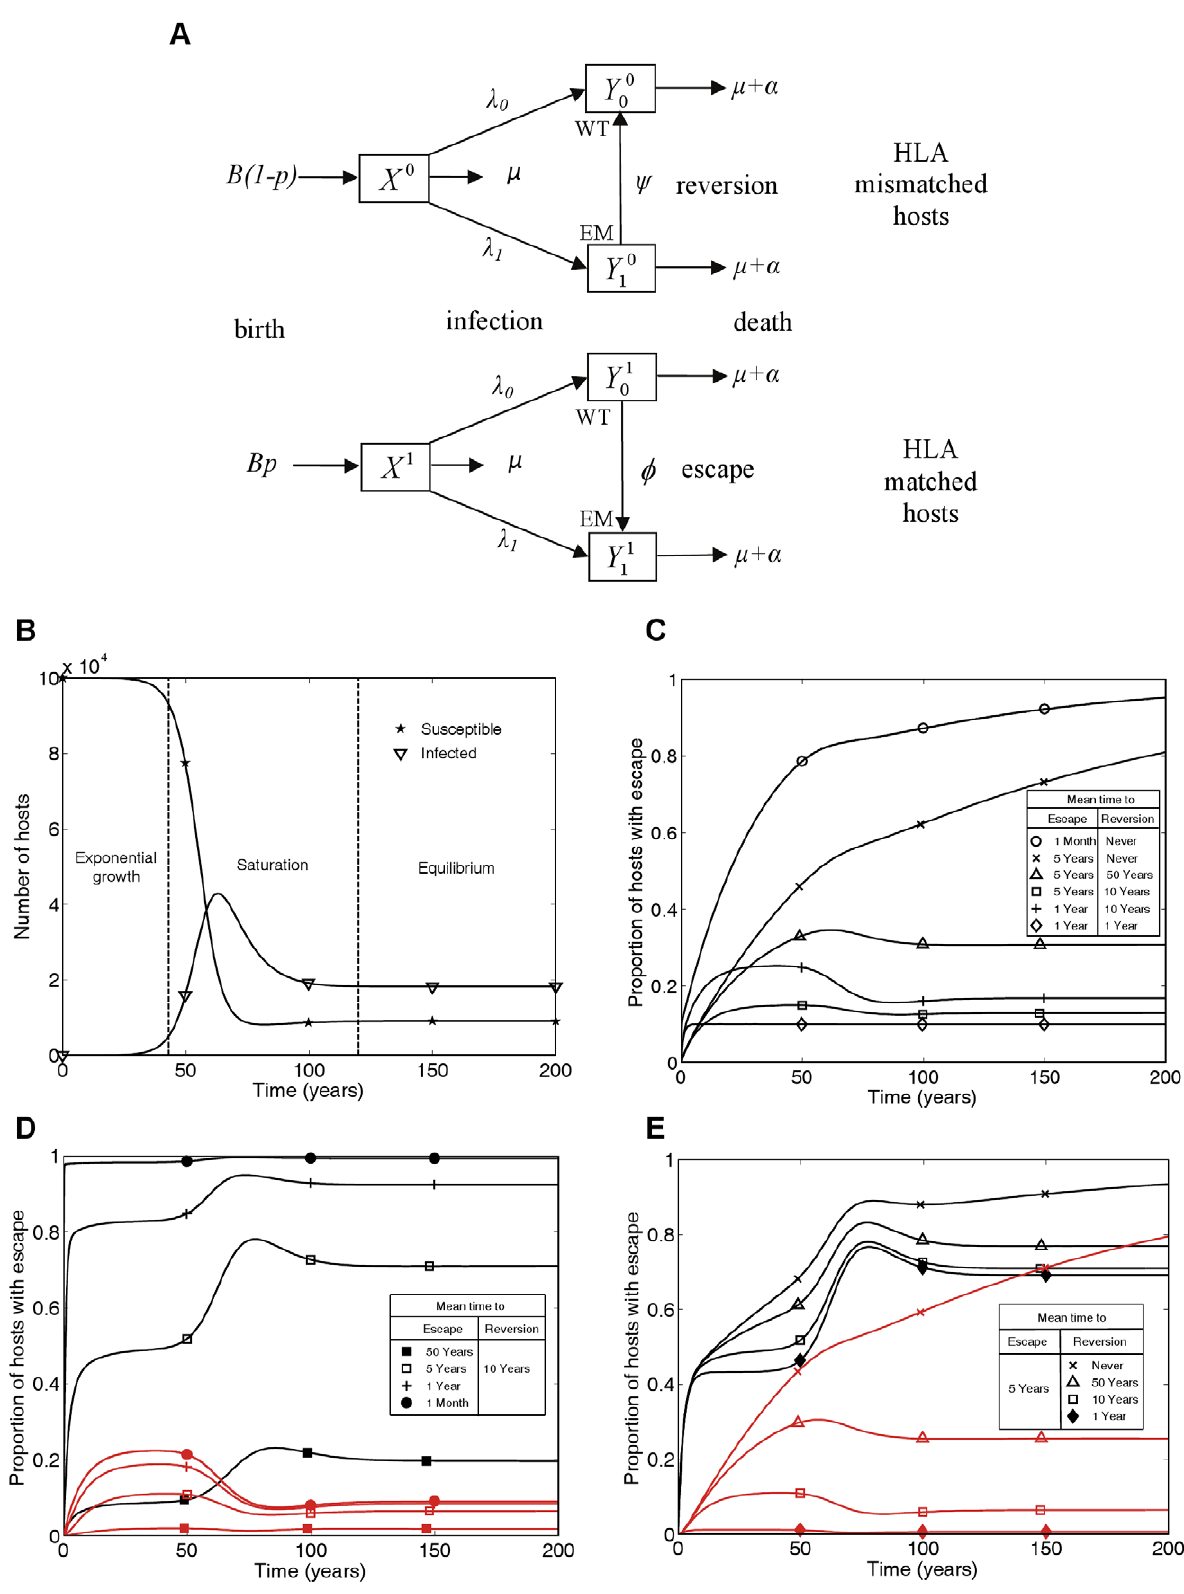
Figure 1. A mathematical model of within-host evolution and between-host transmission of escape mutants at a single CTL epitope. A) The mathematical model in schematic form, where WT and EM denote the wild-type strain and escape mutant strain, respectively. B) P X h ( t ) ) and infected ( P Y h Changes in numbers of susceptible ( P ( t ) ) hosts over time showing the three phases of the epidemic: exponential v v ~ 1,2 h ~ 1,2 h ~ 1,2